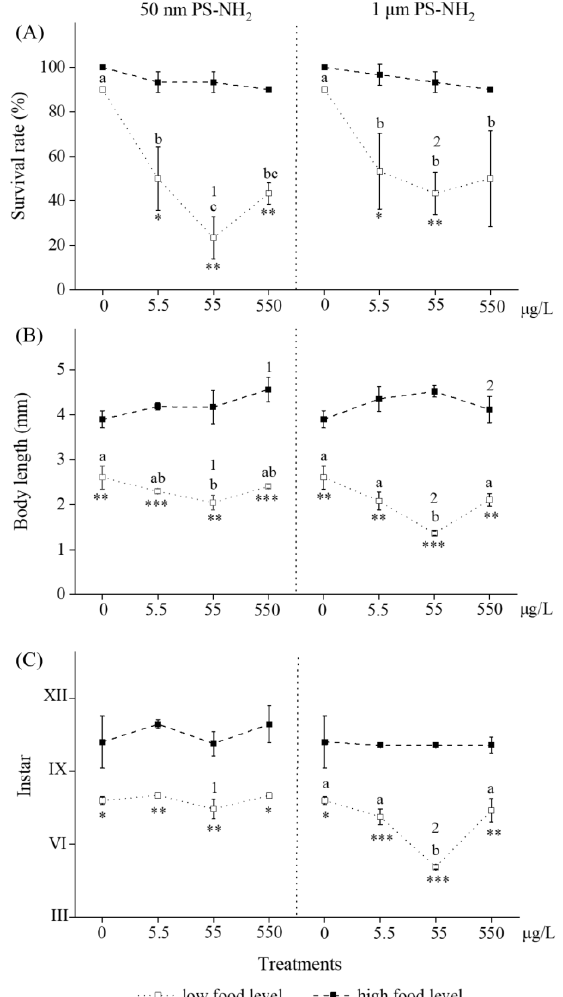
Figure 2. Survival rate (%) ( A ), body length (mm) ( B ), and instar ( C ) for A. parthenogenetica exposed to 50 nm and 1 μm PS-NH 2 for 14 days. Data were analyzed by three-way ANOVA, and different treatments were compared by Bonferroni multiple comparisons for the analysis of significant dif- ferences. Error bars represent means values ± SD. Different letters/numbers indicate significant differences between exposure groups with different concentrations/sizes ( p < 0.05), while differences between treatments by providing low and high food levels are shown as * ( p < 0.05), ** ( p < 0.01), and *** ( p <0.001).